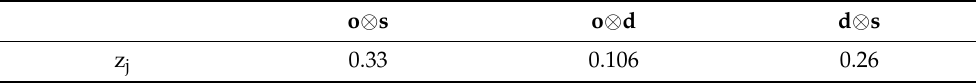
Table 4. Weights of PRISM pattern